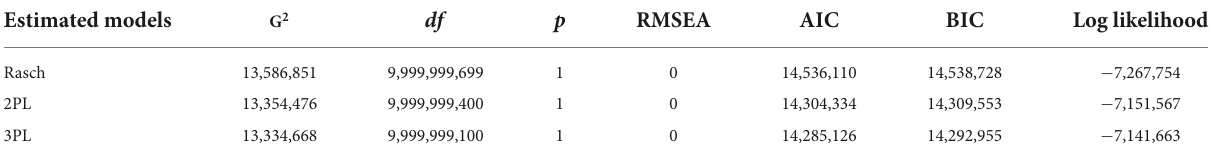
TABLE 2 Model fit statistics for the estimated